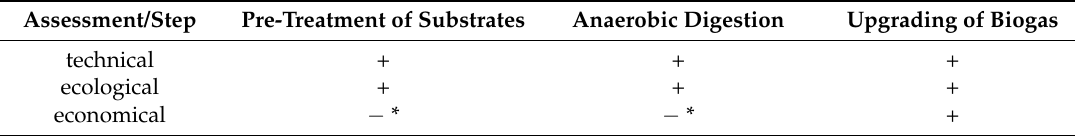
Table 2. Assessments per technology